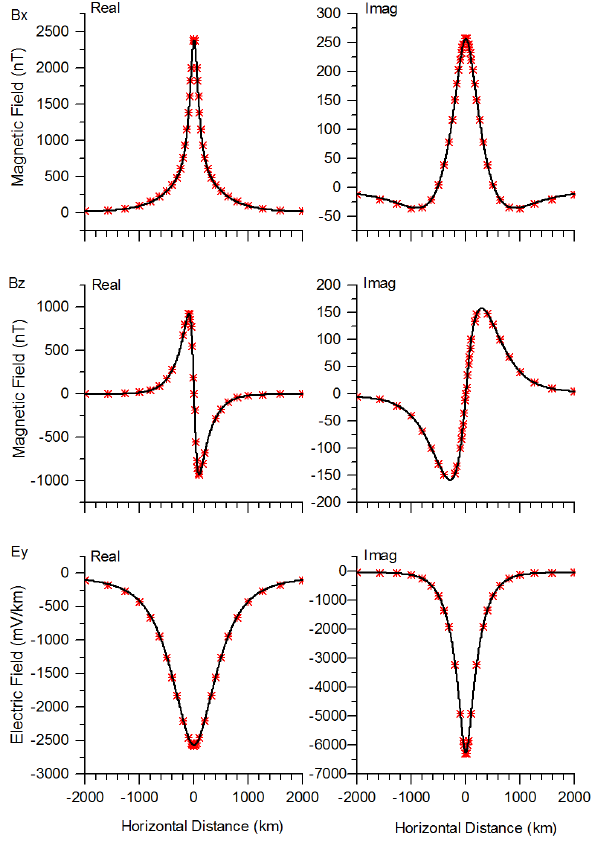
Fig. 3. The electric and magnetic field components at the surface Figure 3. The electric and magnetic field components at the surface for an uniform Earth with 2 for an uniform Earth with a conductivity of 0.001Sm − 1 . The FEM results are the black curve whereas the FHT results are the red sym- a conductivity of 0.001 S/m. The FEM results are the black curve whereas the FHT results 3 bols. The period is are the red symbols. The period is 300 s. 4